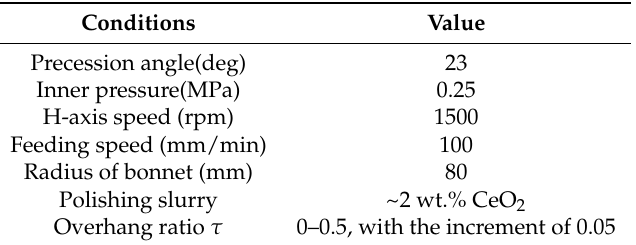
Table 1. Experimental